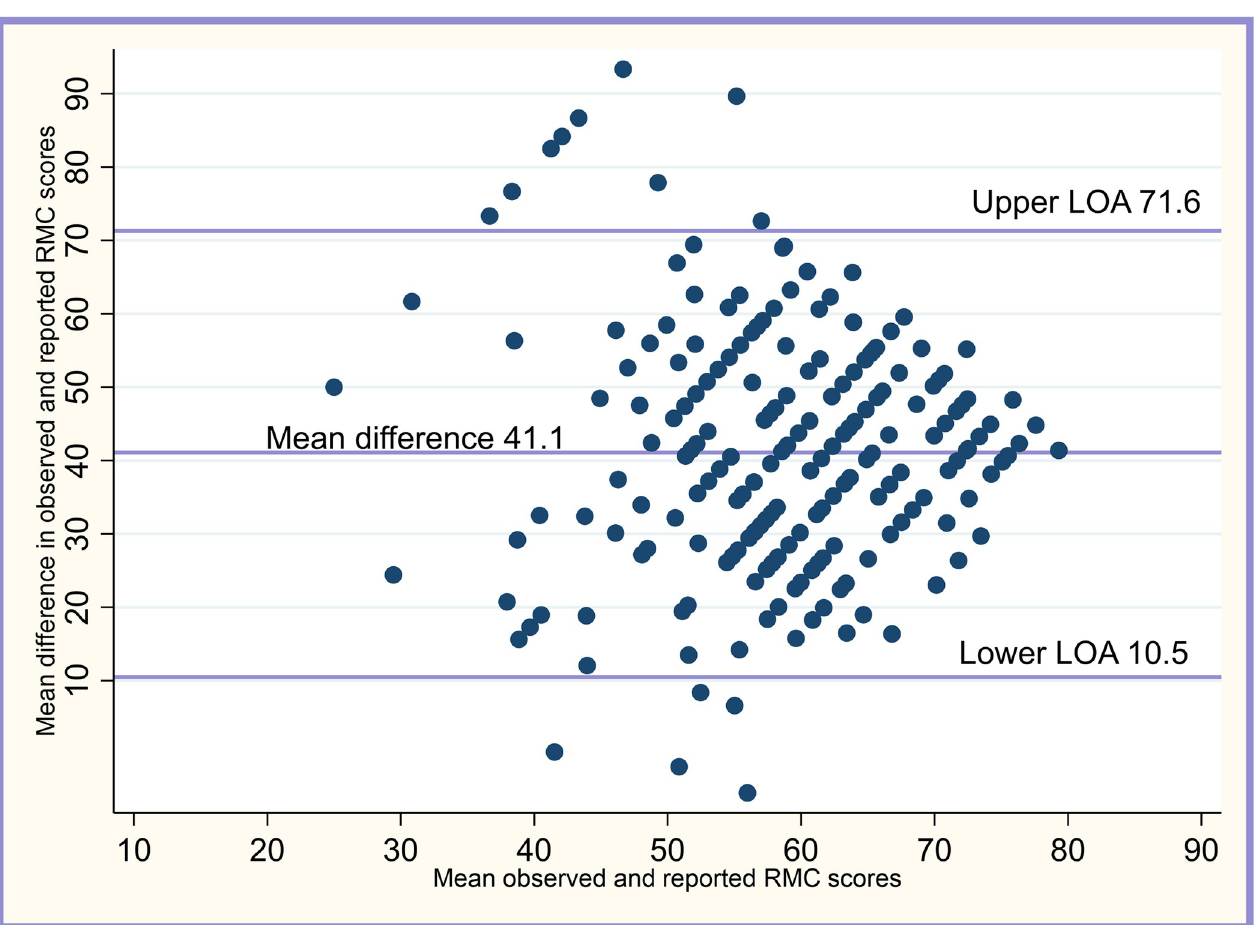
Fig 2. Bland-Altman plot on levels of agreement between observed and reported RMC